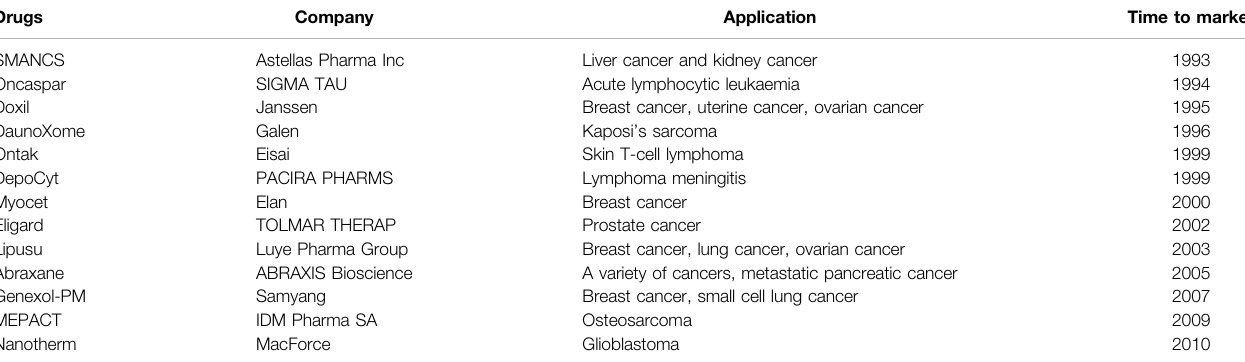
TABLE 3 | Antitumour nanodrugs currently approved for marketing (Danhier, 2016; Liu et al., 2018b).